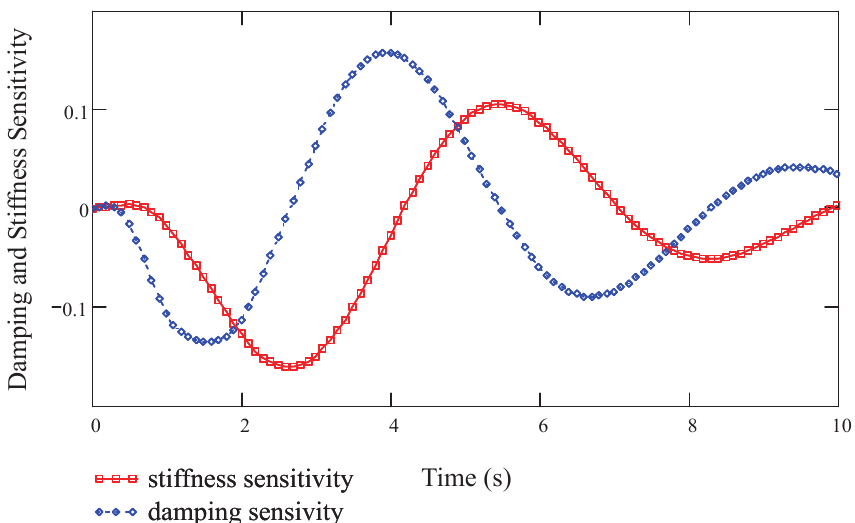
Fig. 7. Model sensitivity to perturbations in damping and stiffness coef fi